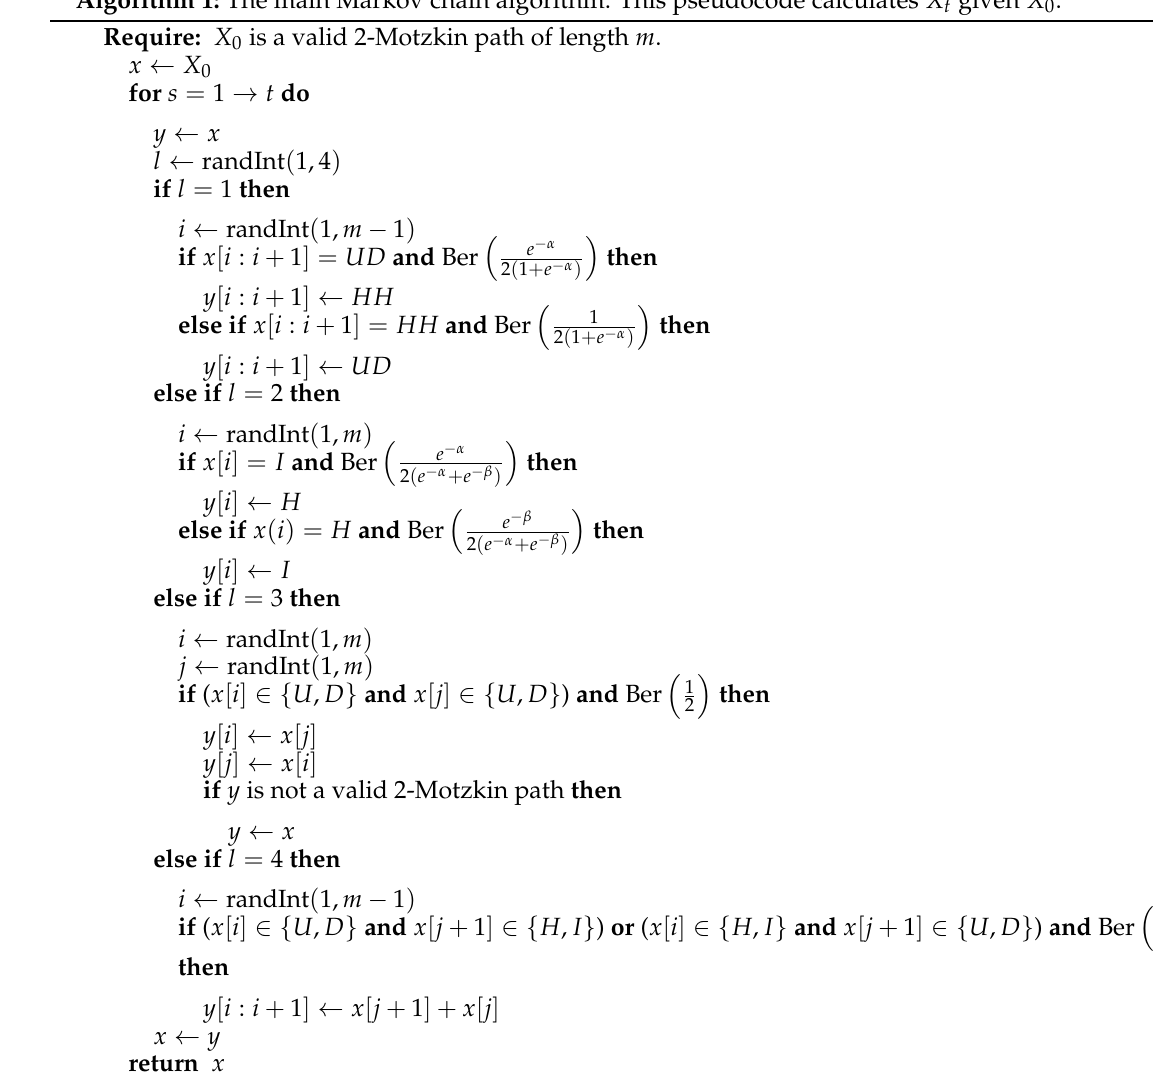
Algorithm 1: The main Markov chain algorithm. This pseudocode calculates X t given X 0